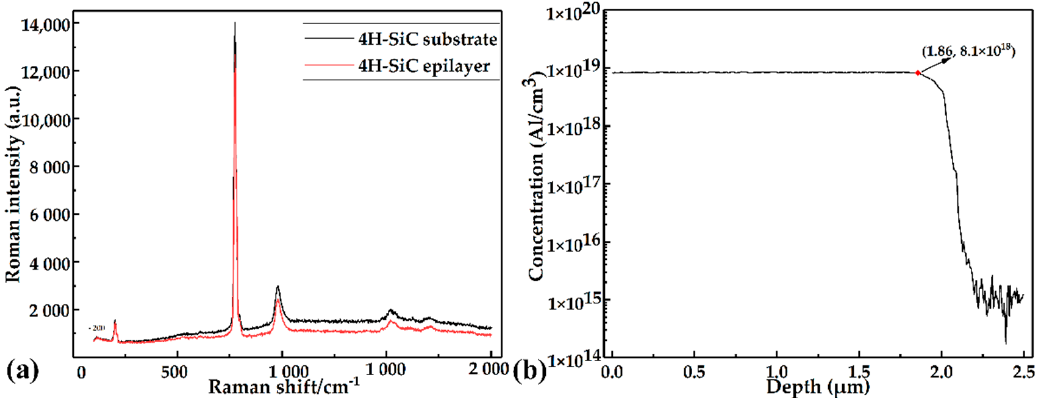
Figure 4. Characterization test of SiC epitaxial layer. ( a ) Raman spectra of epitaxial layer and substrate. ( b ) Secondary ion mass spectrometry (SIMS) pattern of the aluminum element in the epitaxial layer.